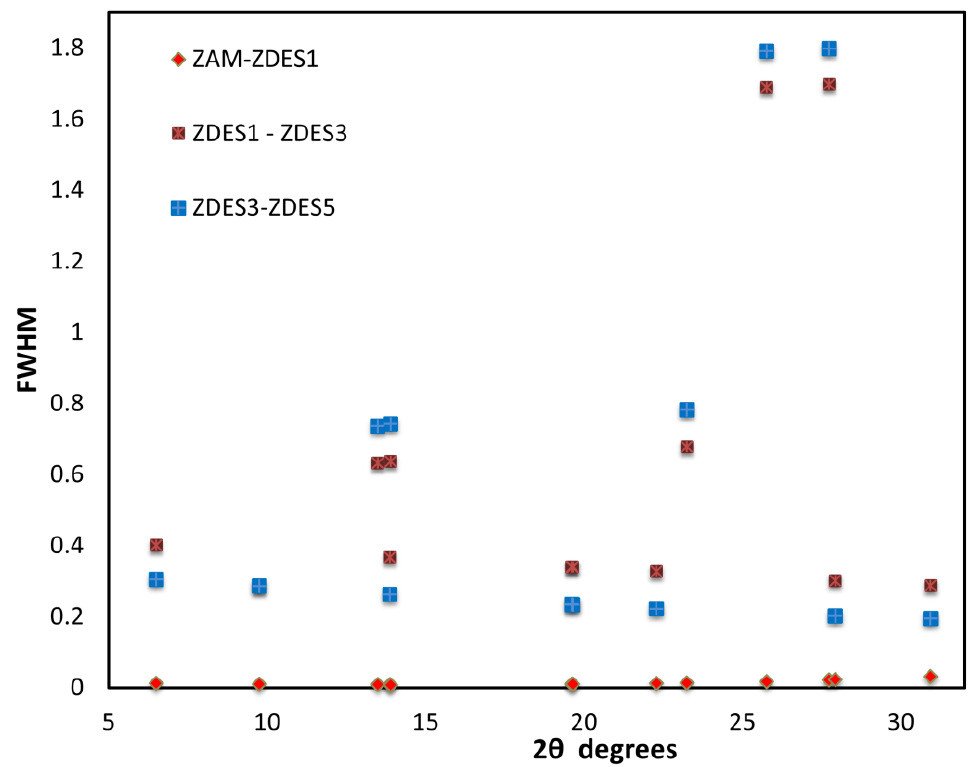
Figure 3. Differences in peak width H w versus 2 θ of the raw material (ZL); ammonia-exchanged sample (ZAM); and dealuminated samples (ZDES1, ZDES3, and ZDES5) . Table 1. Unit-cell parameters and volume of the raw material (ZL); ammonia-exchanged sample (ZAM); and dealuminated samples (ZDES1, ZDES3, and ZDES5) *. Samples